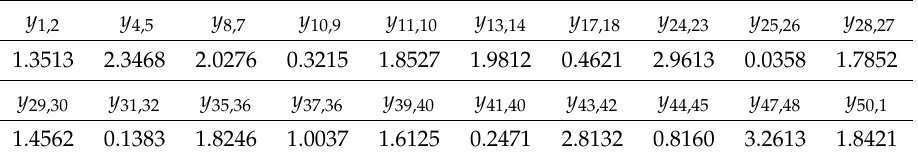
Figure 4. The profit vs. fleet size for a 50 parking region DBSS. Table 3. The expected number obtained by MVA and FES